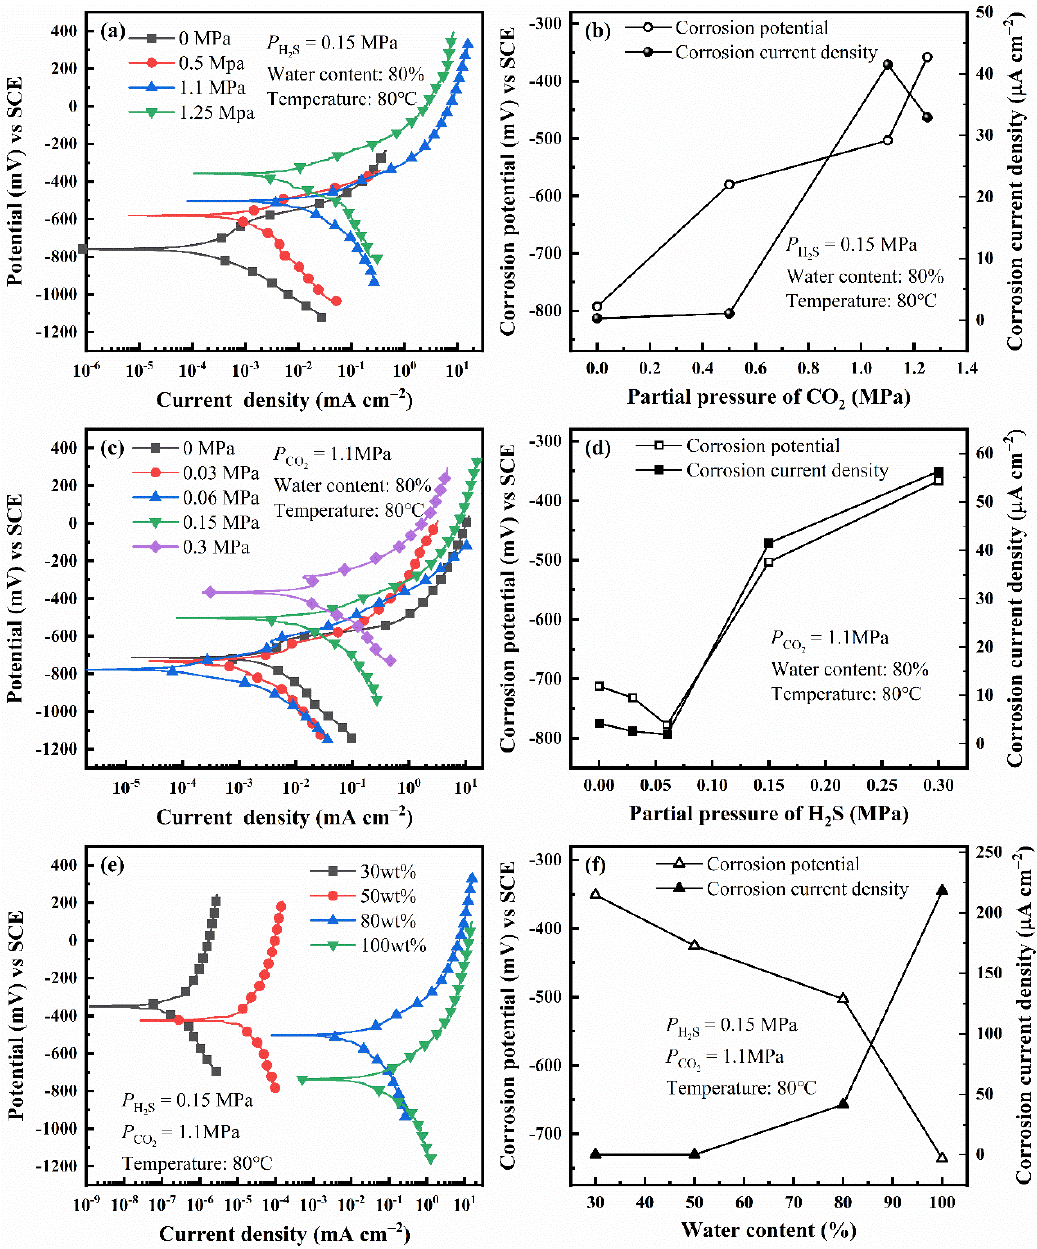
Figure 4. Polarization curves and fitting results of L80 steels under different partial pressure of CO 2 ( a , b ), different partial pressure of H 2 S ( c , d ) and different water content ( e , f ).